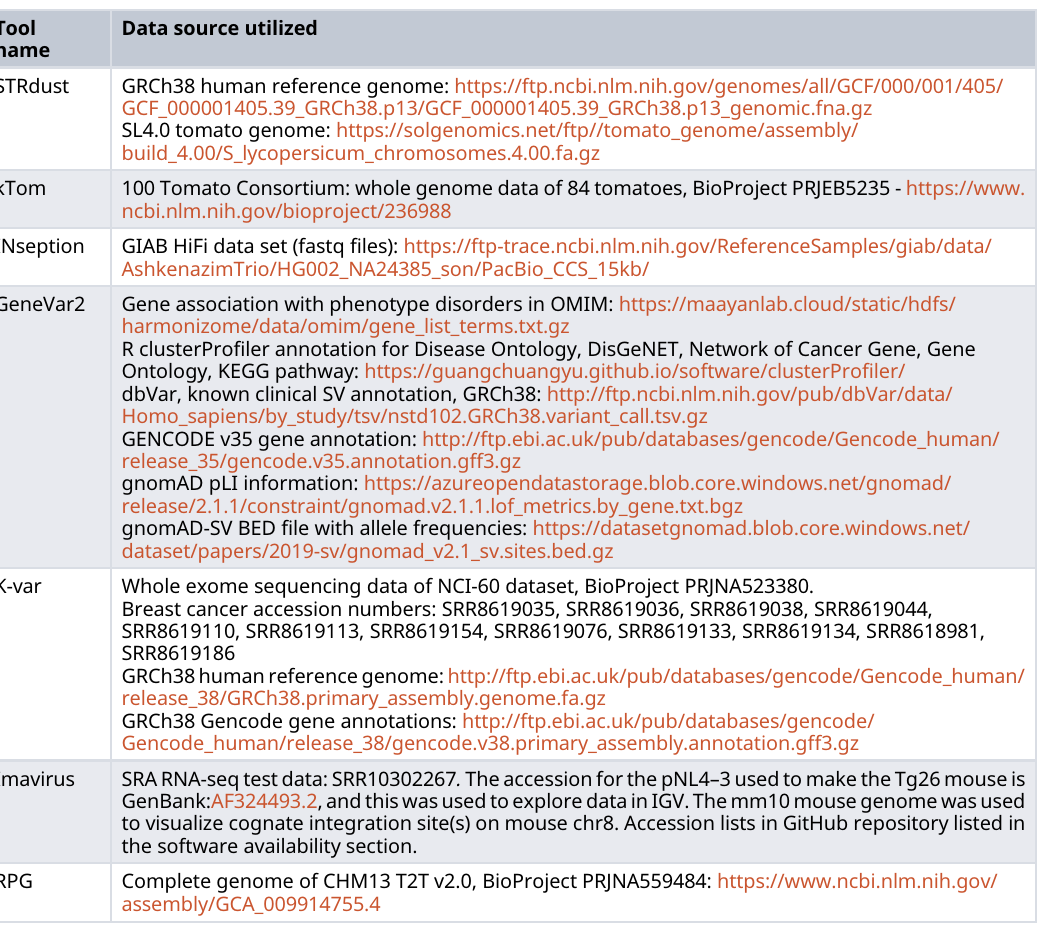
Table 1. Lists the data source utilized by each tool developed during the hackathon. Tool